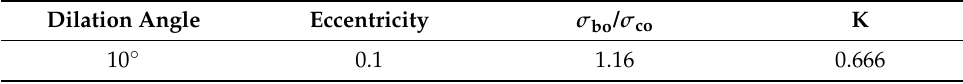
Table 3. The default parameters of CDP Material Model.